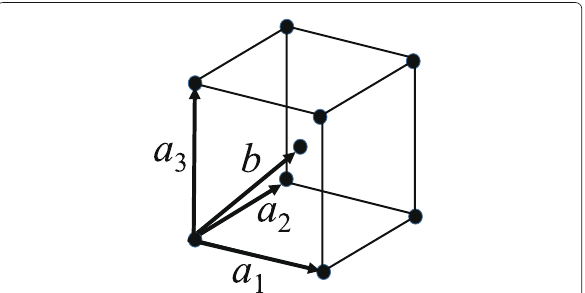
Fig. 5 Body centered cubic (BCC) lattice. The unit cell of the BCC lattice is illustrated by a 1 , a 2 , a 3 and b , where b = ( a 1 + a 2 + a 3 )/ 2